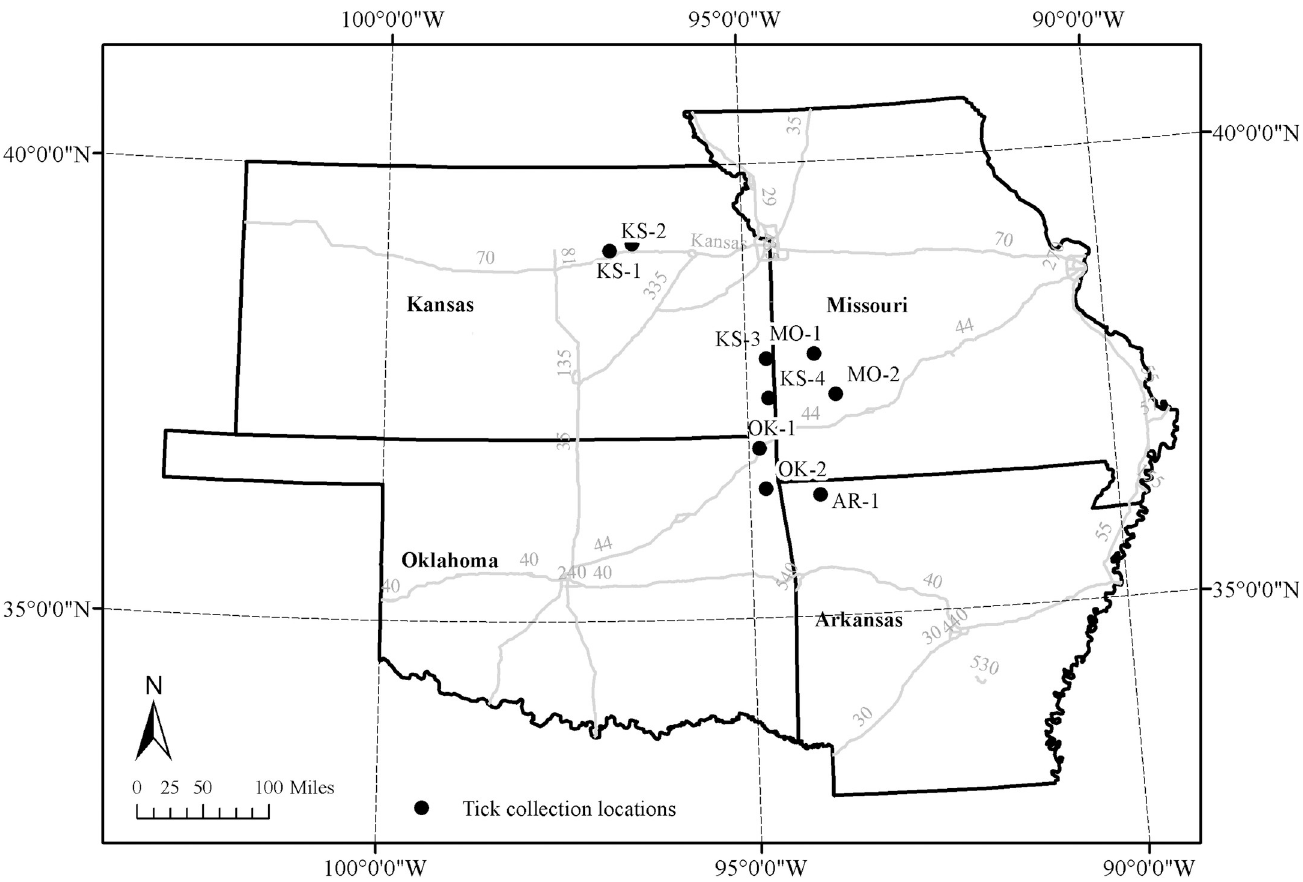
Fig 1. Locations where questing ticks were collected during the winter months of January and February of